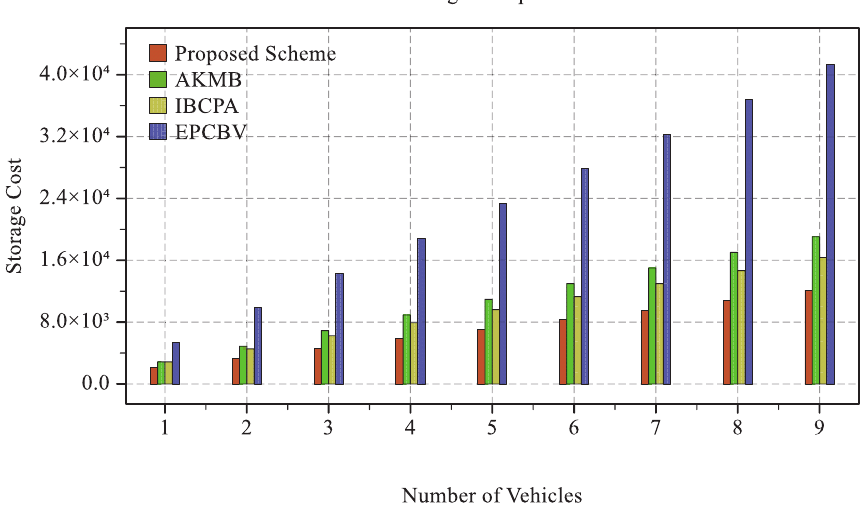
Figure 3. Comparison Results of Storage